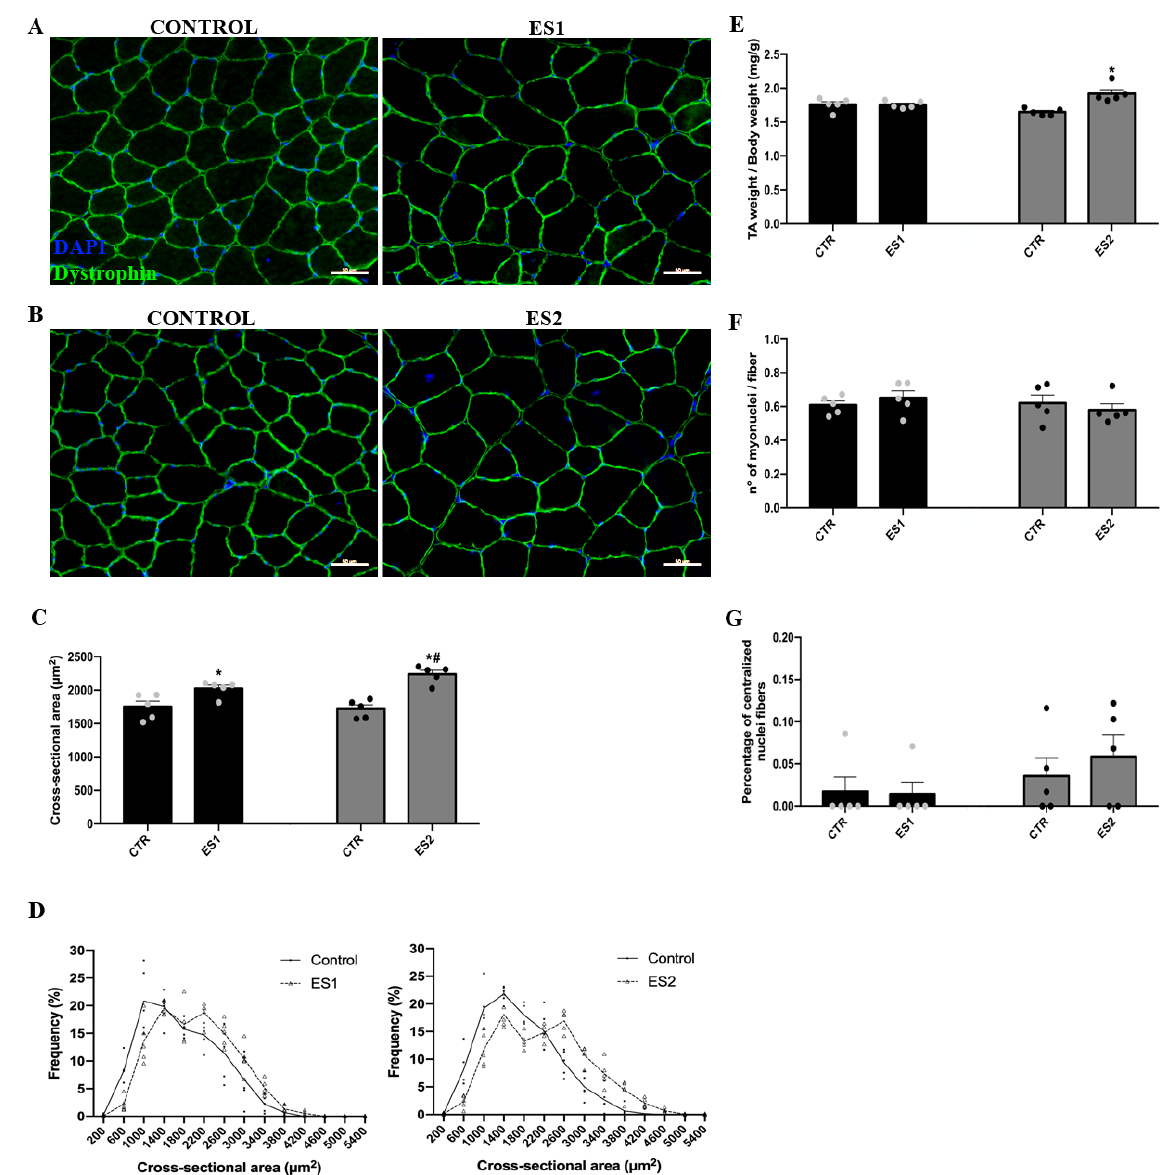
Figure 1. Morphometric and myonuclei counting analyses after one and two weeks of electrical stimulation are depicted. ( A , B ) are representative photomicrographs of dystrophin (green) immu- nofluorescence (DAPI in blue, used to identify nuclei) in TA muscle after one and two weeks of electrical stimulation, respectively (50 μm scale bar). ( C ) Mean fiber cross-sectional area of the TA muscle following one and two weeks of electrical stimulation (n = 5). ( D ) Distribution of fiber cross- sectional area after one and two weeks of electrical stimulation (n = 5). ( E ) TA muscle mass analysis after one and two weeks of electrical stimulation (n = 5). ( F ) Quantity of myonuclei per fiber follow- ing electrical stimulation for one and two weeks. ( G ) Percentage of fibers containing centralized nuclei following electrical stimulation for one and two weeks. The data were displayed as mean ± SEM. Two-way ANOVA was followed by Tukey ’ s post-test in the statistical analysis. Three inde- pendent experiments were conducted. * p < 0.05 versus control and # p < 0.05 versus ES1.